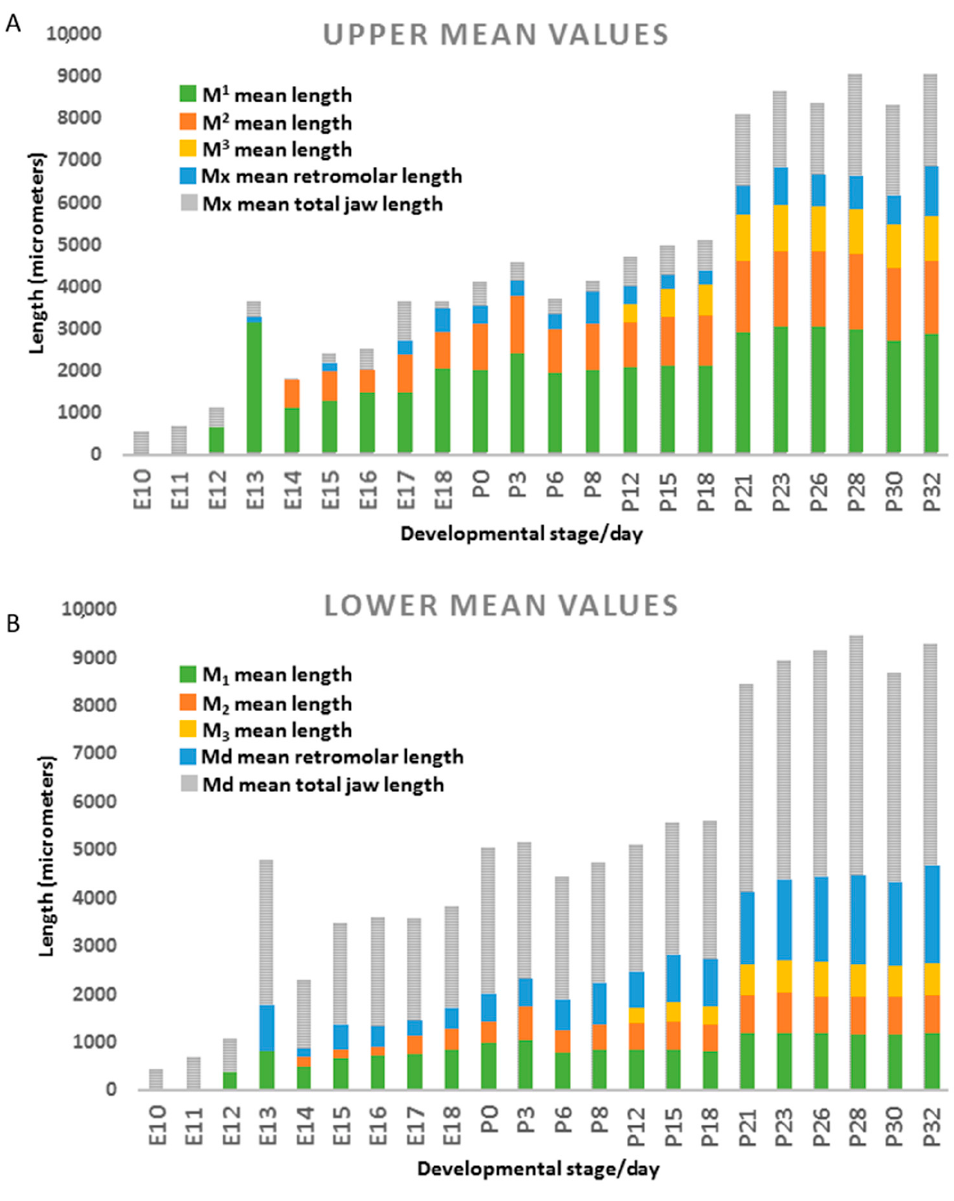
Figure 3. For the ( A ) maxillary prominence (embryos E10–E18) or upper jaw (postnatal mice, P0–P32), and the ( B ) mandibular prominence (E10–E18) and lower jaw (P0–P32), this histogram shows mean mesiodistal lengths of the first (M1L, green), second (M2L, orange) and third (M3L, gold) molar, retromolar space (RML, blue) and entire jaw (TJL, grey). Measurements are averaged among the specimens available for each stage/age. In both jaw types: at E10–E11, no molars have started to form; M1 appears by E12, M2 by E14, and M3 by P12; jaw growth is rapid until E18, after which growth slows, spikes at P21, and slows again (P23–P32). The main differences in the upper jaw are: 1) a much shorter retromolar length (~2–10% of total jaw length) compared to the lower jaw (~10–28% of total jaw length), and 2) upper molars are longer than lower molars. In both jaw types, molars follow a trend of M1 > M2 > M3, but lower molar proportions are closer to M1 > M2 >/= M3. In the upper jaw, the M2 initiates despite very little (~100 µm) of retromolar space. Assuming birth around E20 [32], the duration of molar organ morphogenesis and crown mineralization is about 17–19 days for all three molar types in upper and lower jaws. The periods of M1 and M2 formation almost entirely overlap with each other, and overlap with M3 onset and morphogenesis, but barely overlap with the period of M3